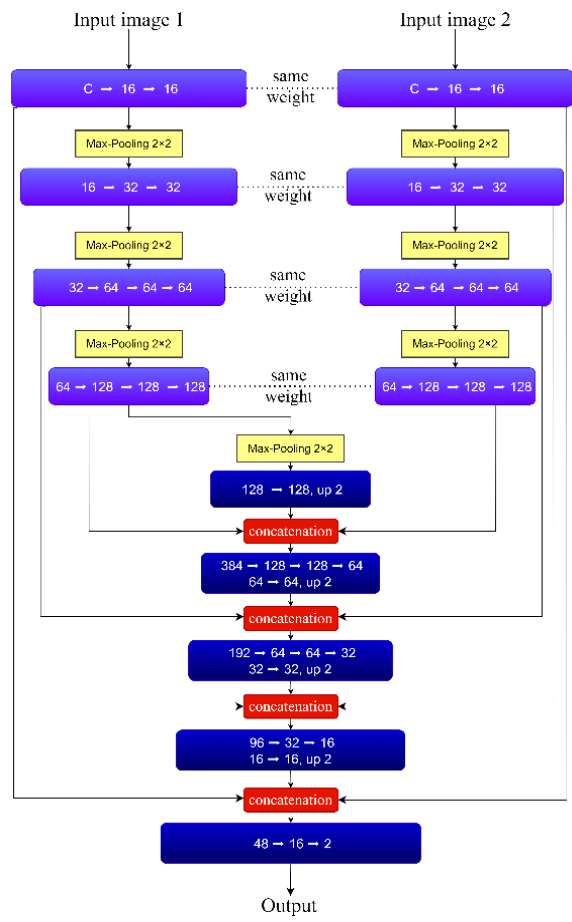
Figure 2. FC-Siam-conc network architecture. Dark blue and purple rectangles represent convolution and transpose convolution respectively.